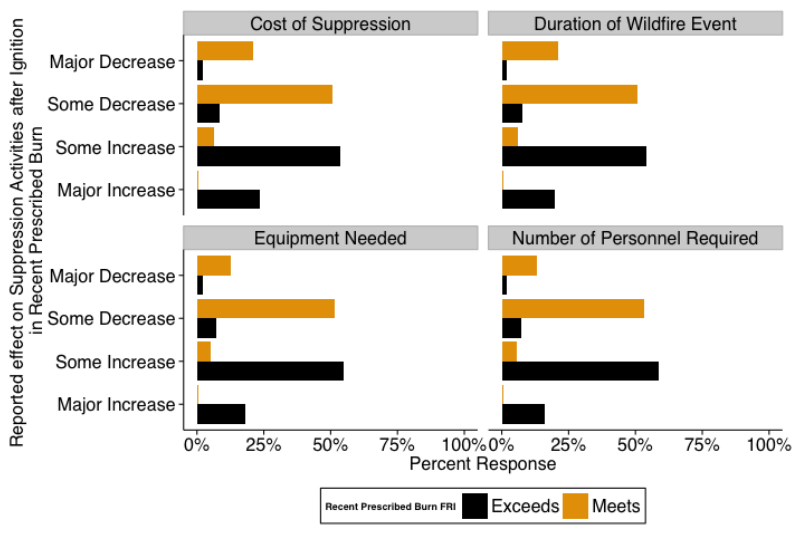
Figure 6. Manager reported impact of deviation from desired fire return interval on wildfire suppression costs and complexity. Black bars show responses where prescribed burn interval has exceeded ( i.e., not met) the desired return interval; yellow bars show responses for wildfires occurring where desired prescribed burn intervals had been